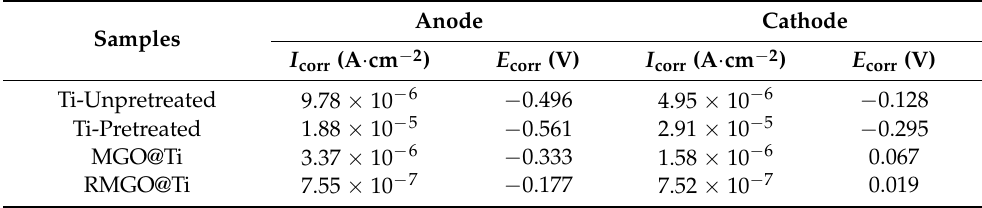
Table 1. Potentiodynamic I corr and E corr of samples in the simulated proton exchange membrane fuel cell (PEMFC) environment.